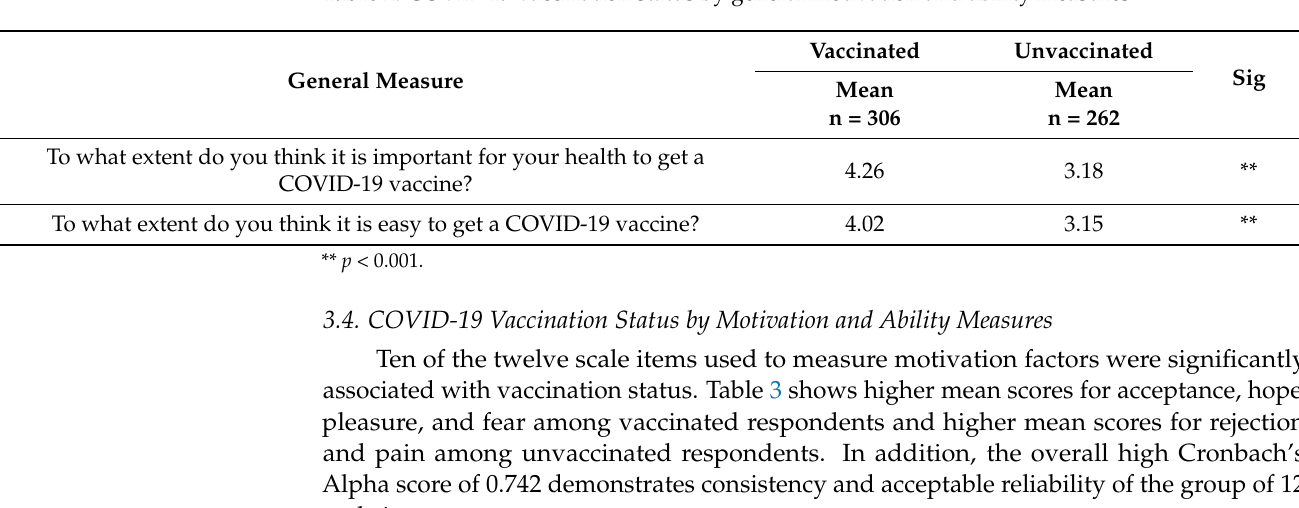
Table 2. COVID-19 vaccination status by general motivation and ability measures.